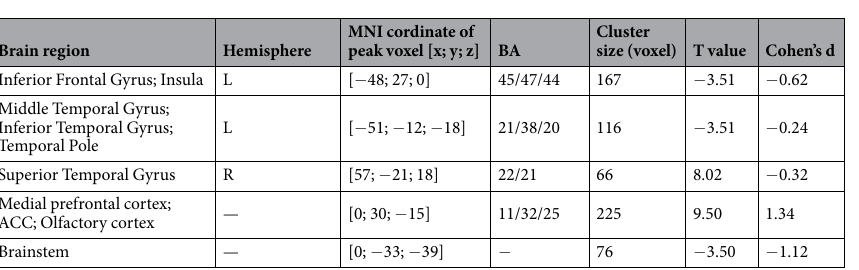
Table 2. Brain regions showing significant treatment effect of ALFF between baseline and post-treatment in CCRT